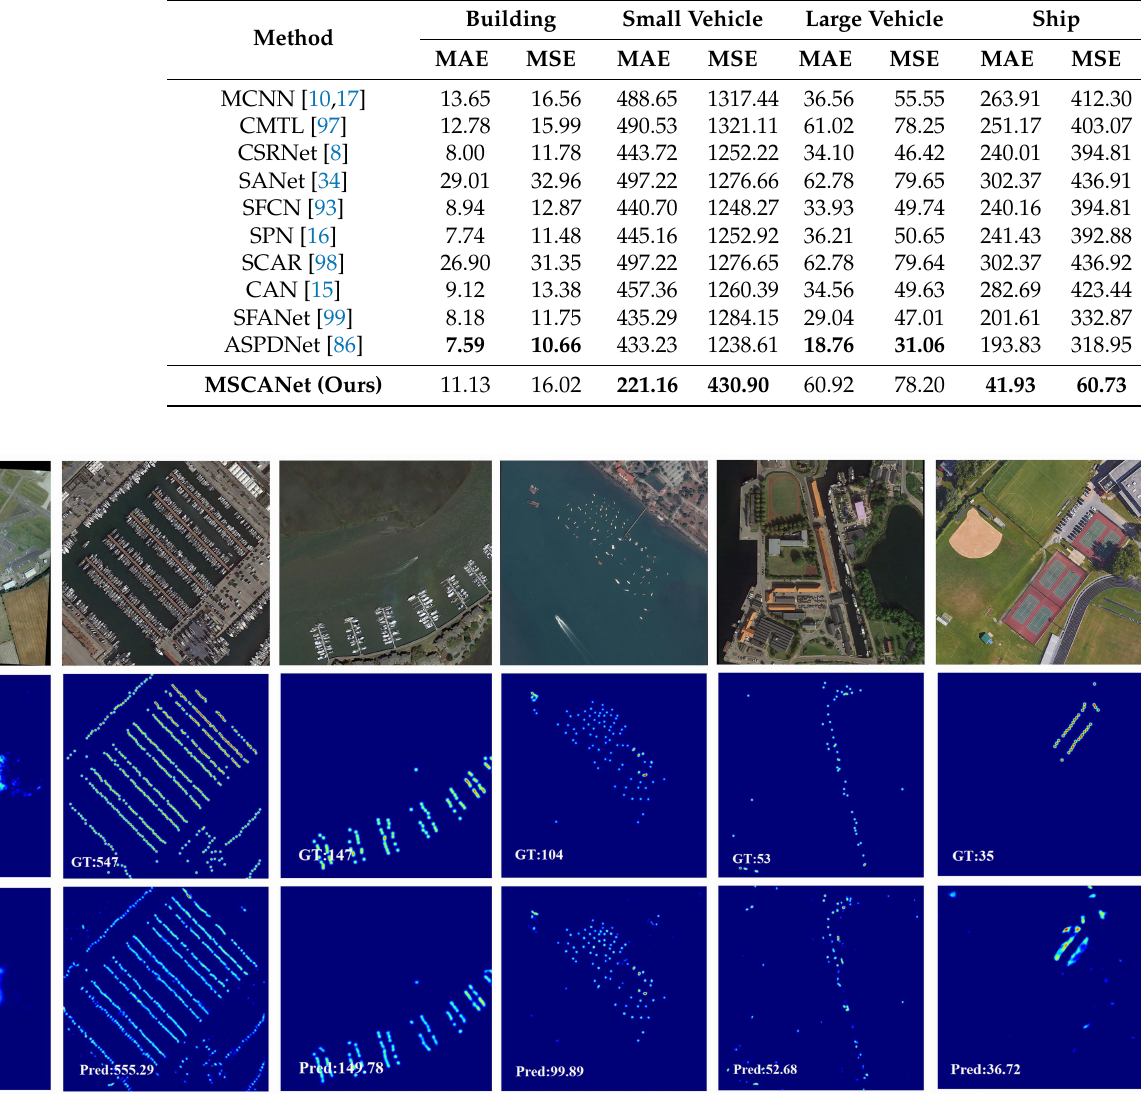
Figure 5. Visualization results of MSCANet for remote sensing object counting on RSOC